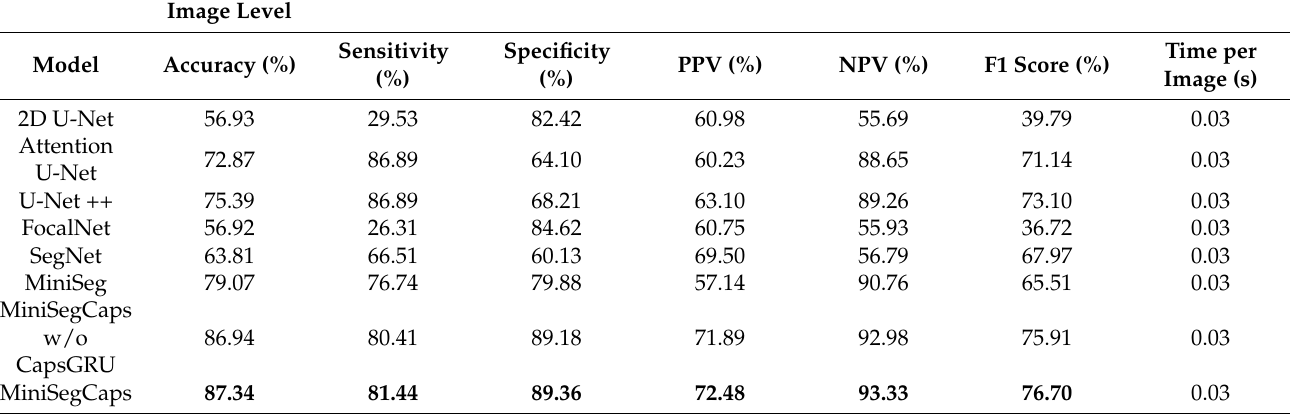
Table 9. Comparison of the image-level performance between our method and baseline methods in prostate cancer classification on PI-RADS = 5.